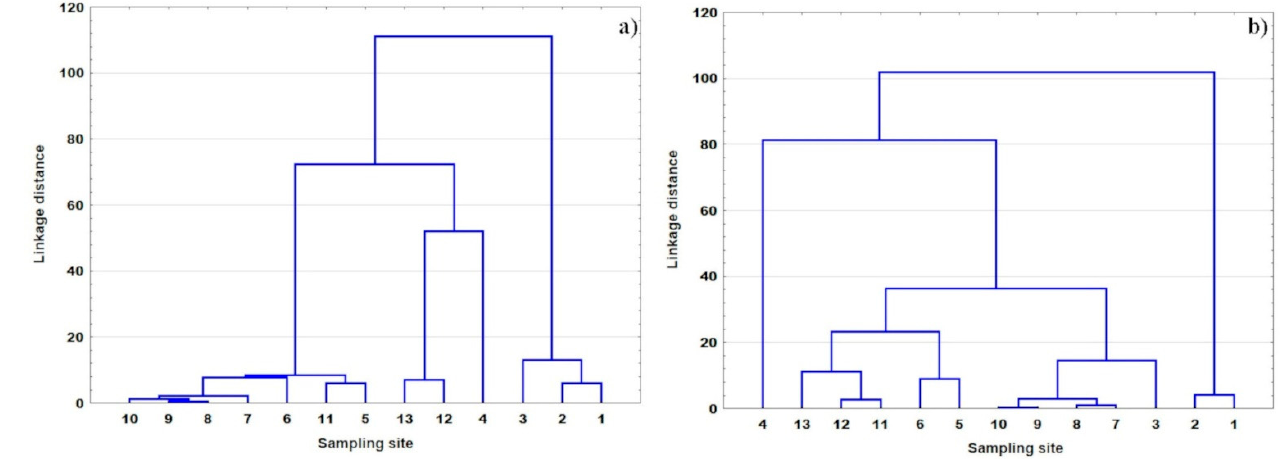
Figure 4. Dendrograms showing sampling sites clustering in ( a ) 2018 and ( b ) 2019.